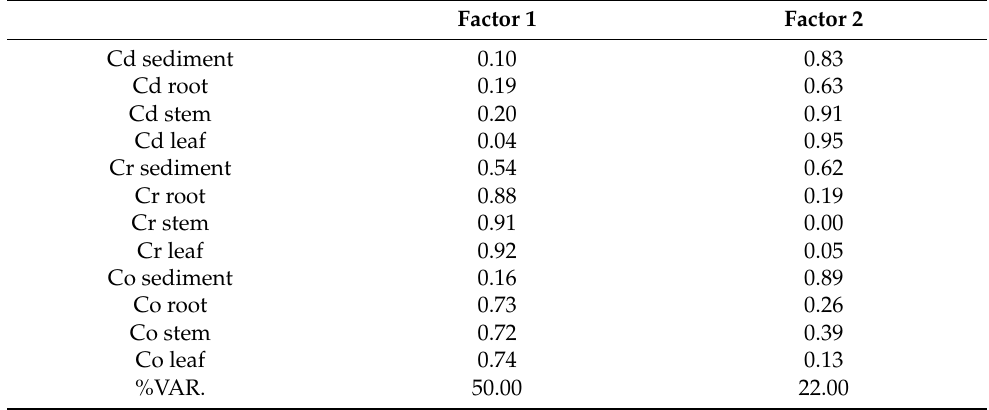
Figure 7. Hierarchical cluster analysis. Table 7. Factor